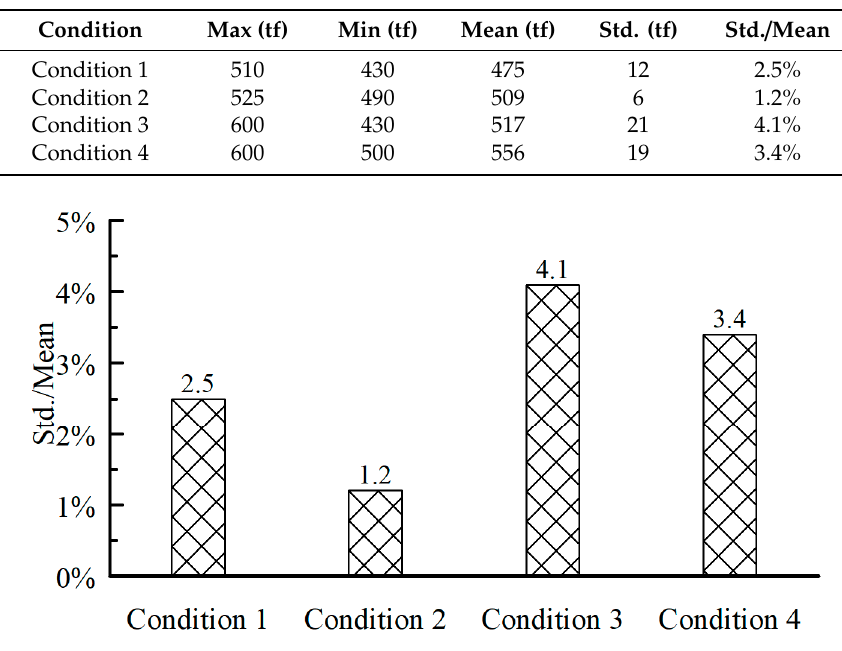
Figure 13. Statistics of the interacting forces.